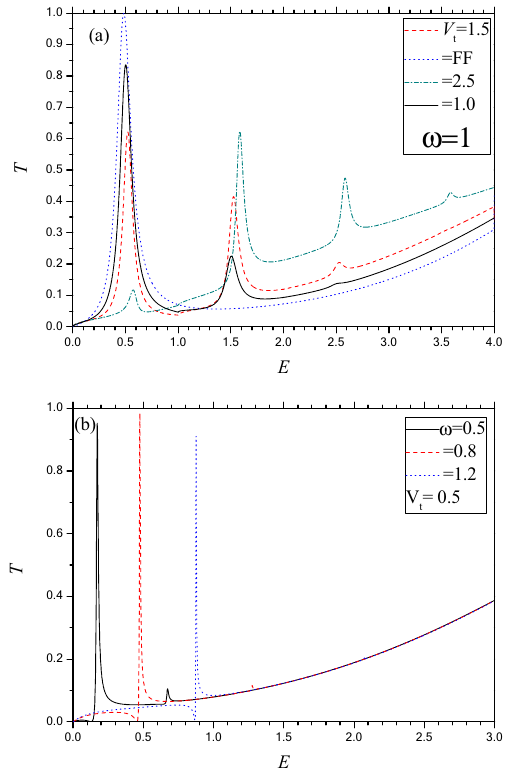
Figure 5. Same as Fig. 4 but for high frequency regime with k y = 0 and D = 1. ( a ) For V 0 = 4 and. ω = 1. Dot (blue) for FF; Solid (black) for V t = 1.0; Dash (red) for V t = 1.5; Dash dot (green) for V t = 2.5. ( b ) For V 0 = 3 and V t = 0.5. Solid (black) for ω = 0.5; Dash (red) for ω = 0.8; Dot (blue) for ω =